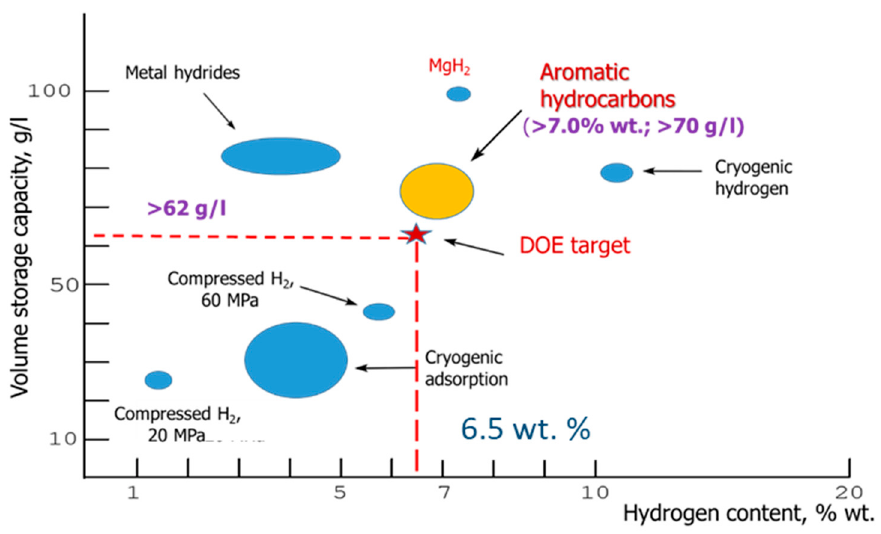
Figure 1. A map of hydrogen storage systems.